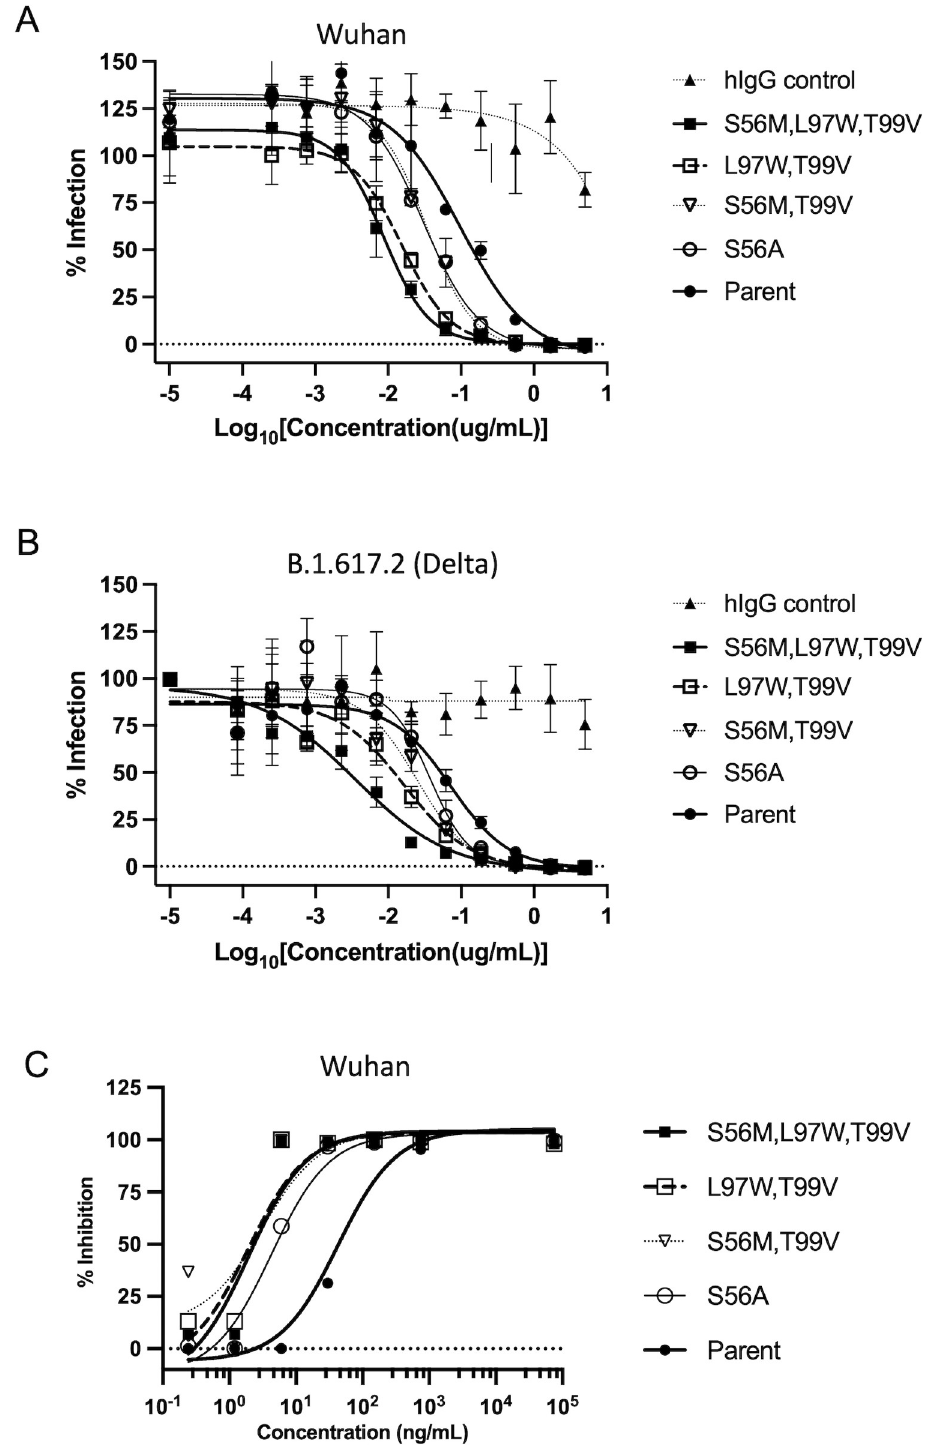
Fig 3. Viral neutralization efficacy by VHH-72-Fc lead mutants. ( A ) Neutralization of VLPs expressing the SARS-CoV-2 Wuhan spike protein for infecting HEK293T cells co-expressing human ACE2 and TMPRSS2. ( B ) Neutralization of VLPs expressing the SARS-CoV-2 B.1.617.2 (Delta) variant spike protein for infecting HEK293T cells co-expressing human ACE2 and TMPRSS2. ( C ) Neutralization of live SARS-CoV-2 Wuhan virus for infecting Vero- E6 cells.